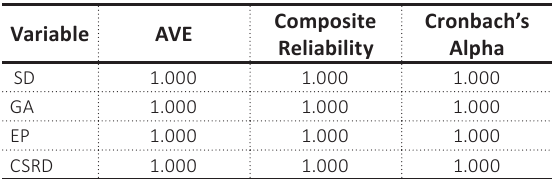
Table 2. Convergent validity and reliability